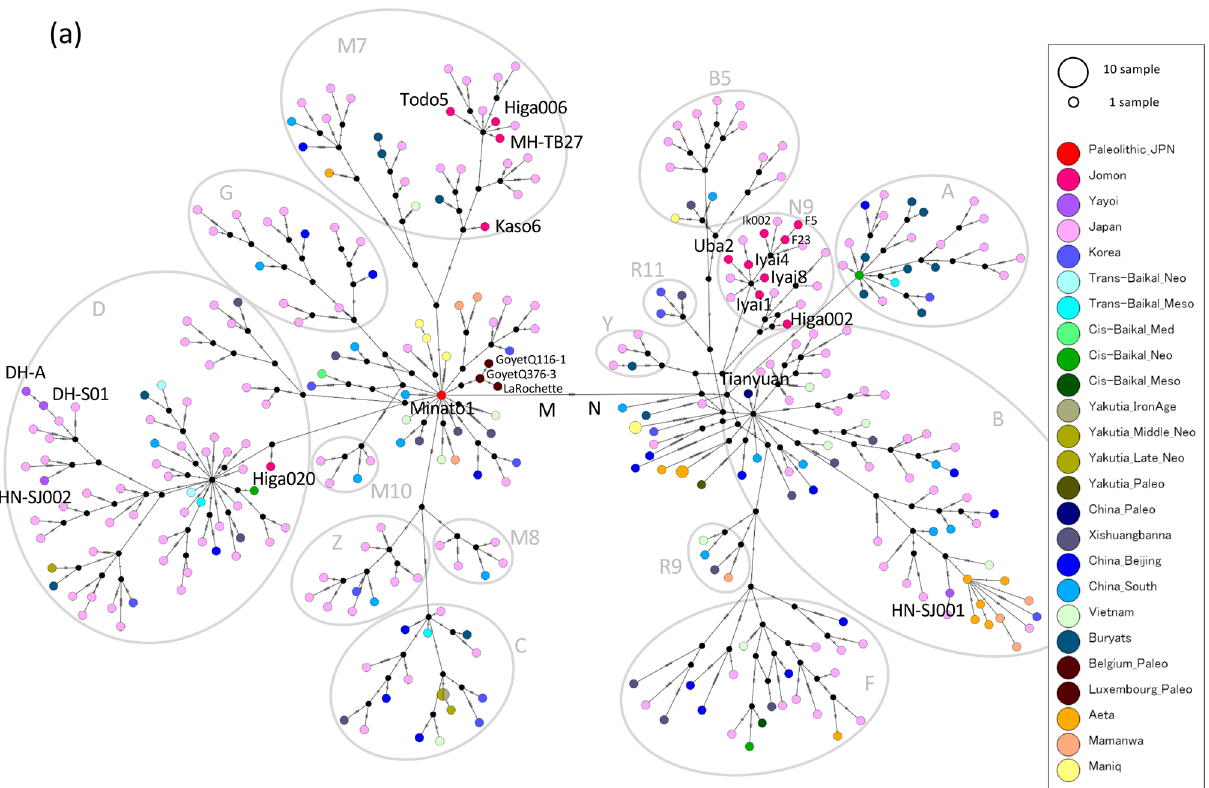
Figure 4. ( a ) A median-joining network for whole coding mitogenome of 37 ancient individuals and 287 present-day Asians belonging to macrohaplogroups M and N. Number of mutations was shown as hatch marks on branches. ( b ) The phylogenetic tree inferred using the Neighbor-Joining method for world-wide 37 ancient individuals and 287 present-day Asians belonging to macrohaplogroups M and N. The samples used here belong to either of macrohaplogroup M (including C, D, G, M7, M8, M10, and Z), and macrohaplogroup N (including A, B, B5, F, N9, R9, R11, and Y). The evolutionary distances for whole coding region of mitochondrial genome, totally 14,918 bp, were computed using the Maximum Composite Likelihood method. The percentage (50% and greater) of replicate trees in which the associated taxa clustered together in the bootstrap test (1,000 replicates) are shown next to the branches. All positions containing gaps and missing data were eliminated (complete deletion